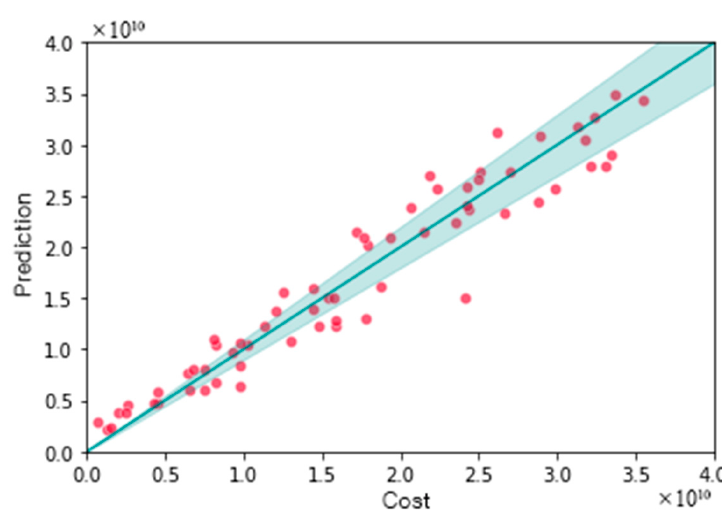
Figure 4. Predictions of single-factor model.